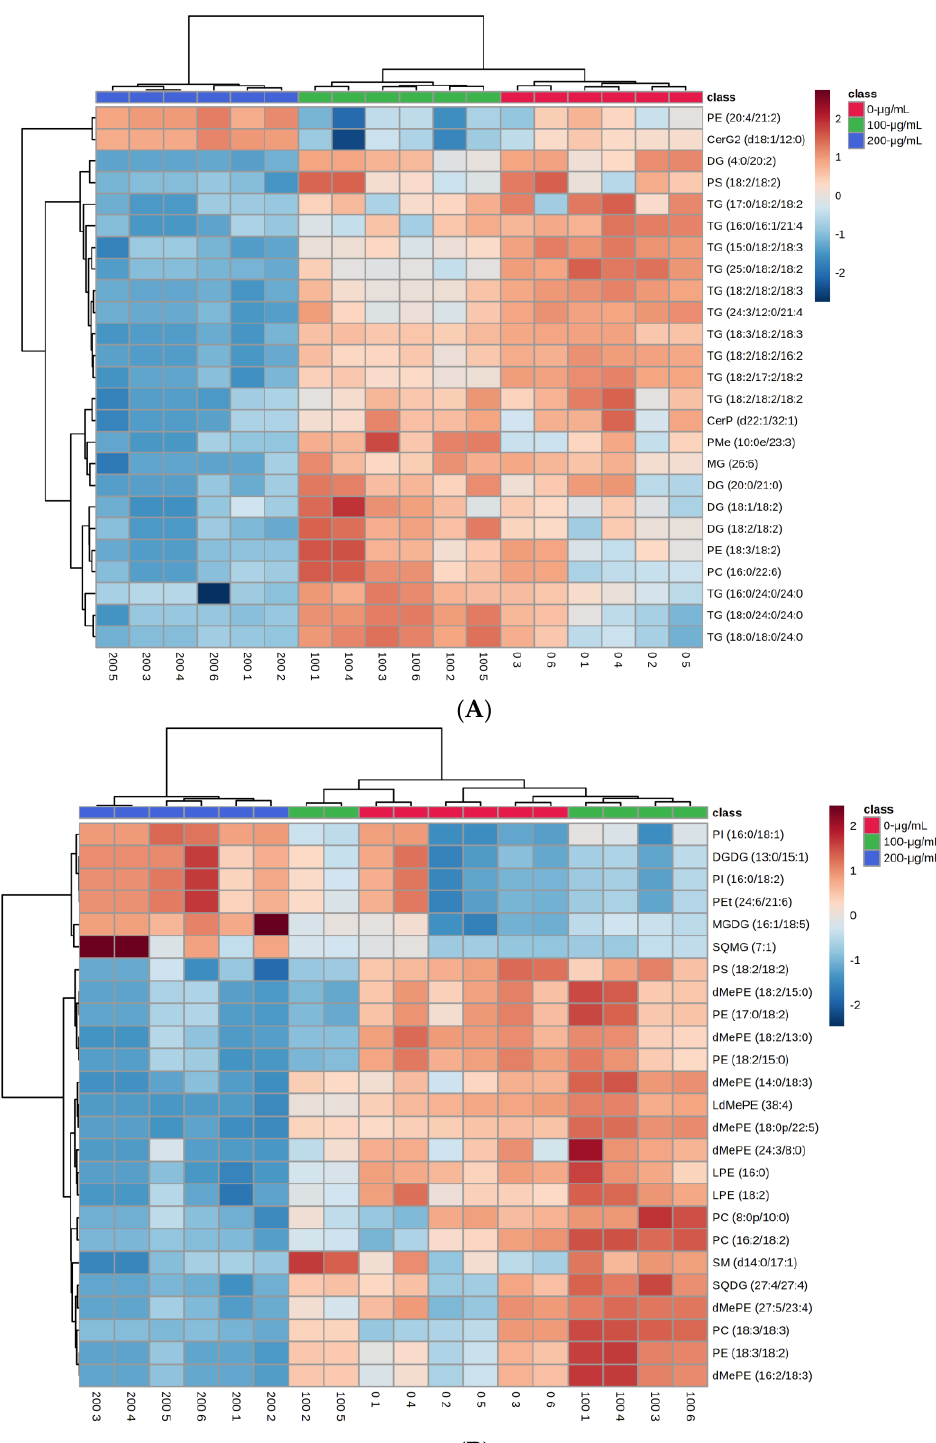
Figure 6. Hierarchical clustering heat map of the 25 top significant differential metabolites, with the degree of change marked with red (upregulated) and blue (downregulated) ( A ) in the positive mode and ( B ) in the negative mode.